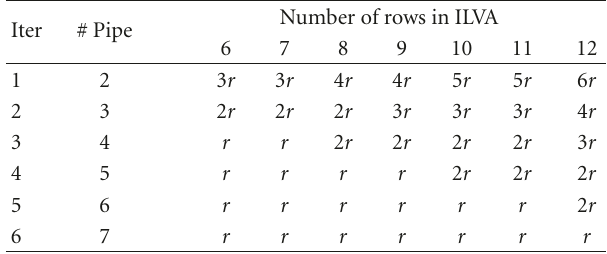
Table 1: The actual number of rows in ILVA as a function of the number of pipelines and number of columns in Caballero with respect to equation (14). Parameter r represents the total number of rows in Caballero.